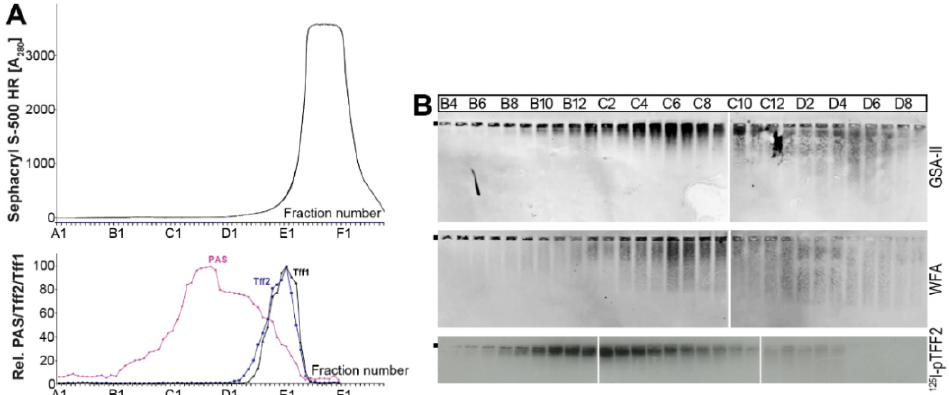
Figure 6. Analysis of a murine gastric extract (9 animals) after reduction in boiling β -mercaptoethanol. ( A ) Elution profile after SEC on a Sephacryl S-500 High Resolution column as determined by absorbance at 280 nm. Underneath: Distribution of the relative Tff1 (black) and Tff2 contents (blue). For comparison, the fractions were analyzed for their mucin content using the PAS reaction (pink). ( B ) 1% AgGE and subsequent Western blot analysis of the mucin-containing fractions B4–D9 concerning Muc6 (lectin GSA-II) and Muc5ac (lectin WFA), respectively. The hybridization signals (autoradiography) obtained after incubating the blot with 125 I-labeled porcine pancreatic TFF2 (pTFF2; overlay assay) are also shown. The start is marked with a dot on the left.